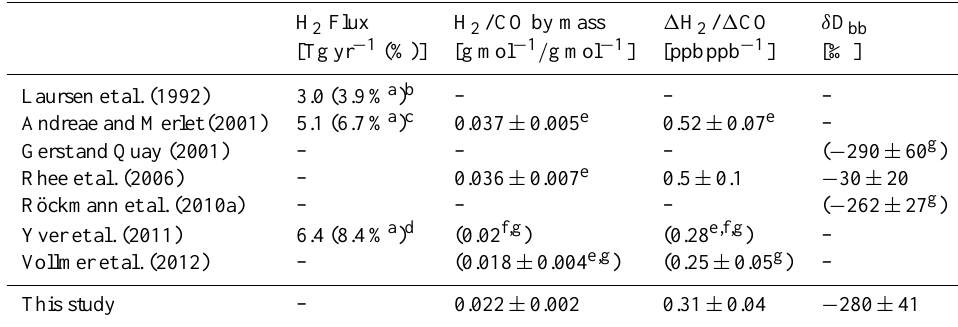
Table 2. Estimates of the tropical biomass-burning H 2 source strength, emission ratio, and isotopic signature.